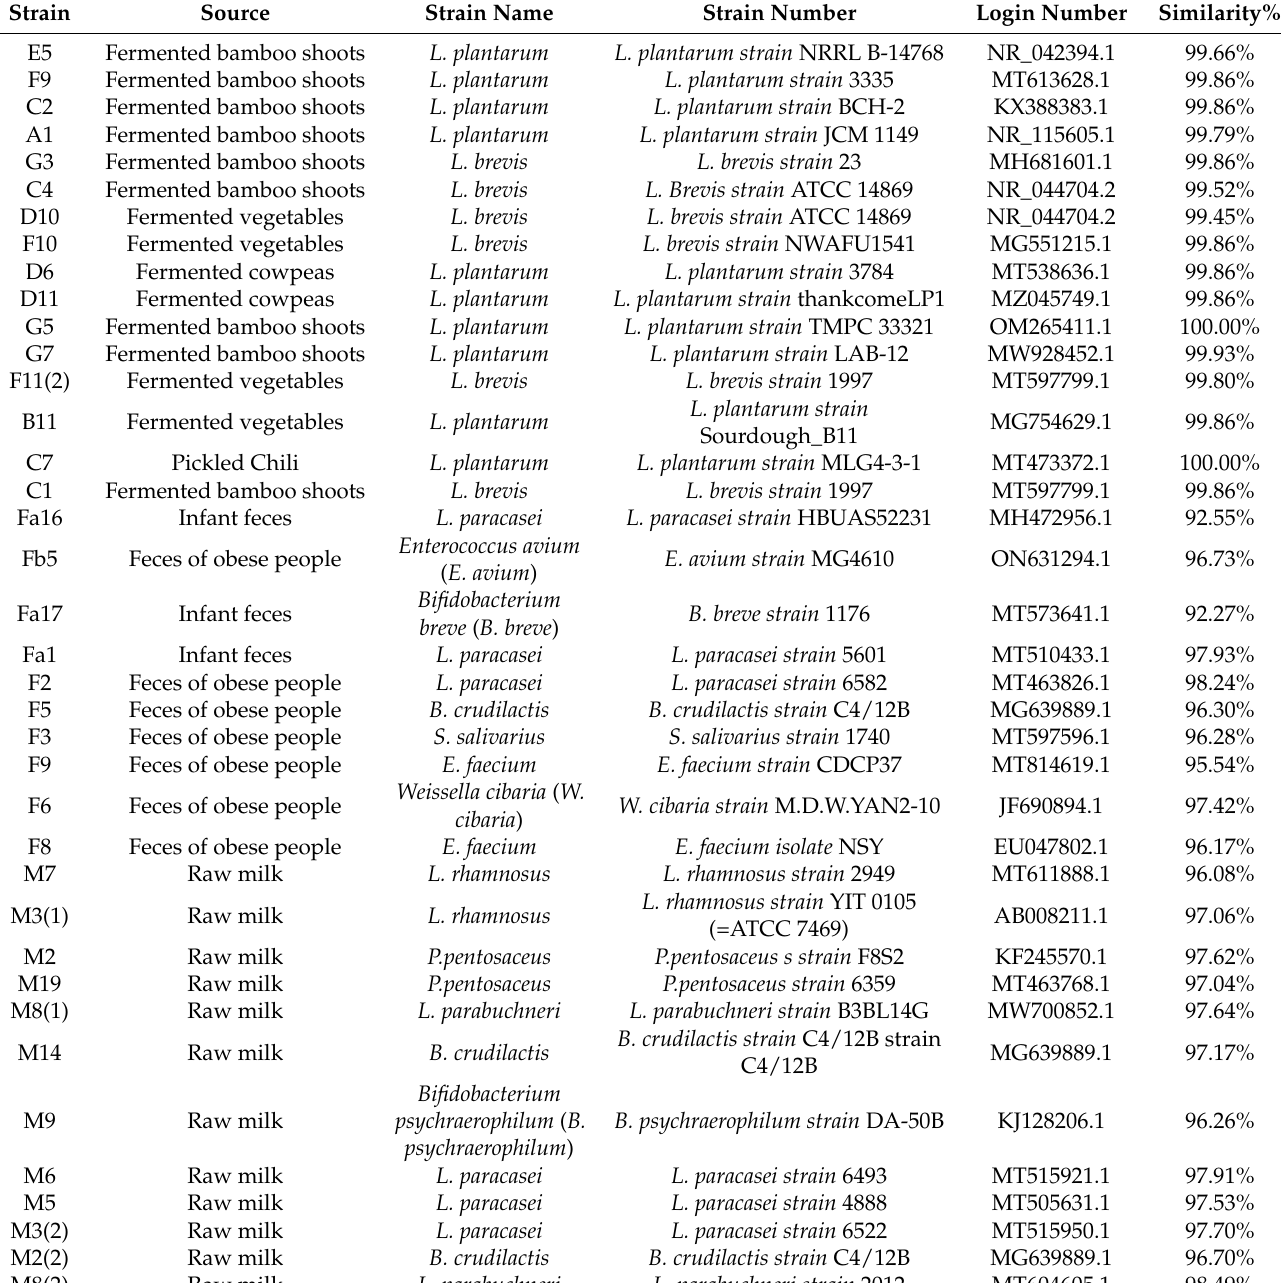
Table 3. Partial comparison results of 16SrRNA sequence homology of screening isolates from different